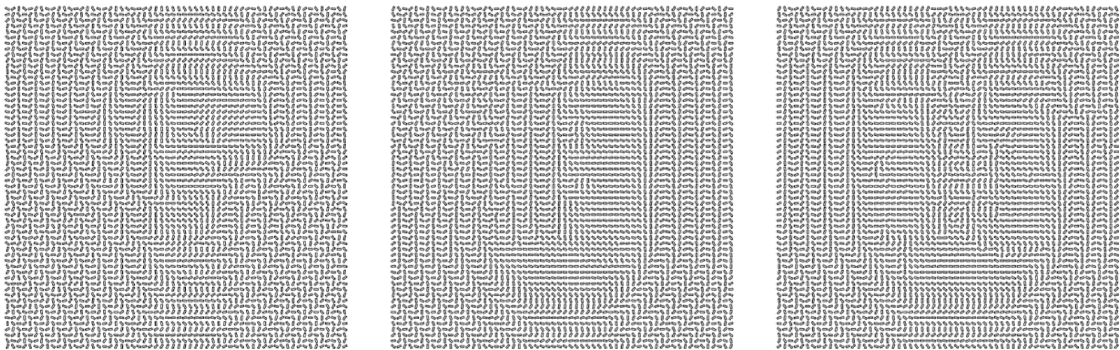
Fig. 10. The metasurface unit structure array of “ T ” , “ J ” and “ U ” .